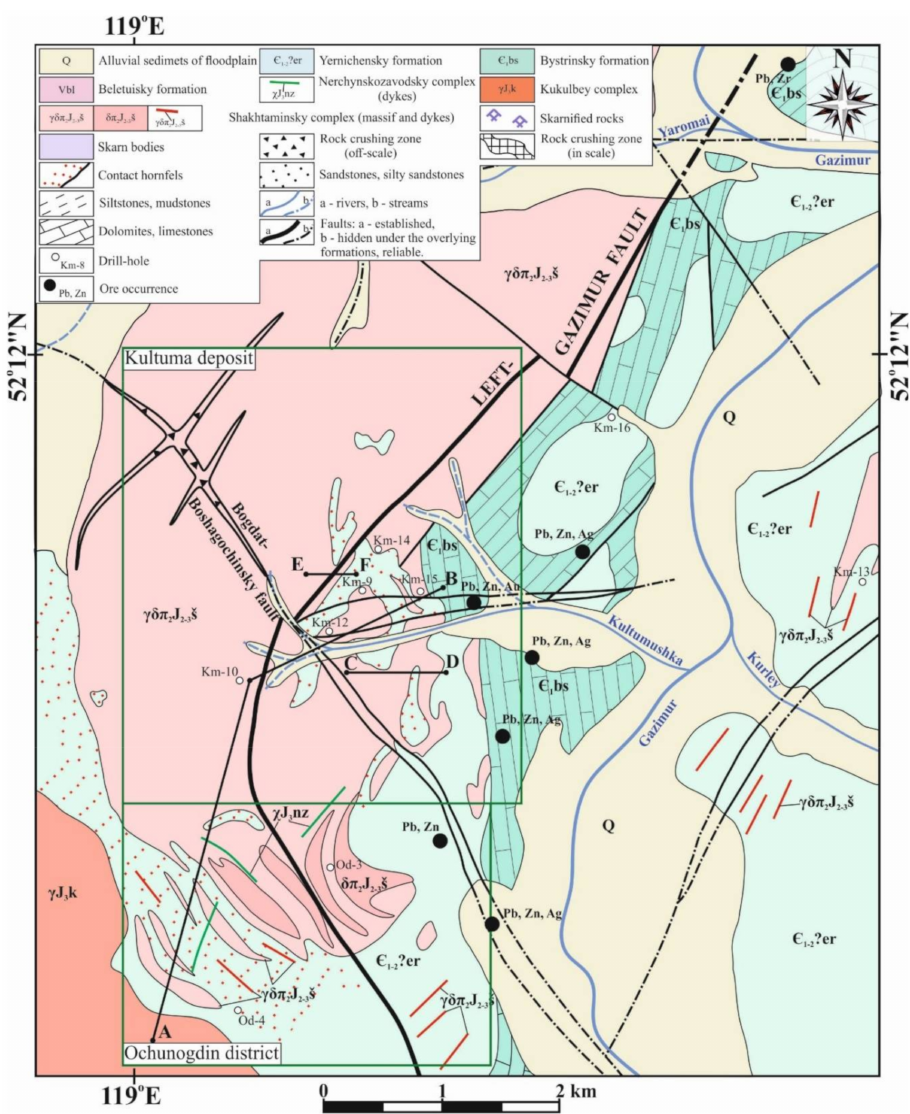
Figure 2. Generalized geological map of the Kultuma deposit (modified after